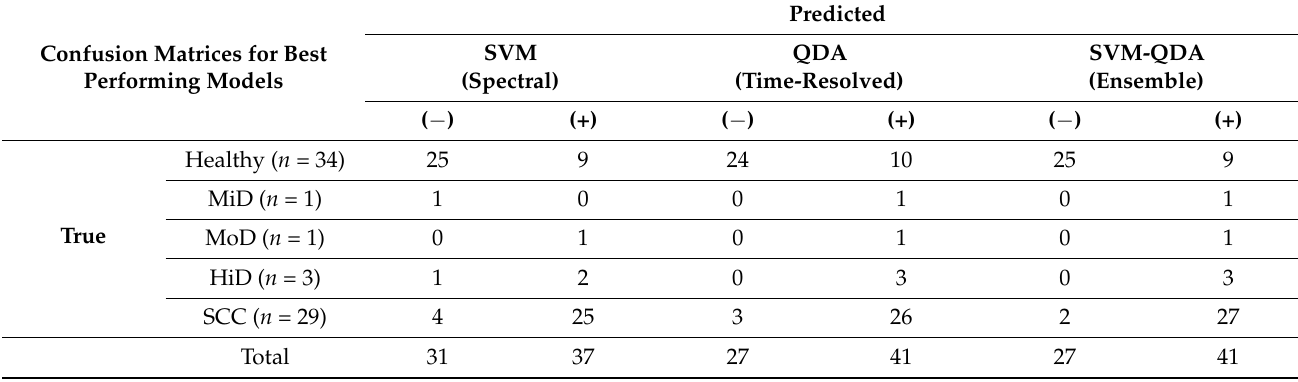
Table 5. Confusion matrices from the 7-fold cross-validation using the optimal model for each maFLIM feature pool (MiD: Mild Dysplasia; MoD: Moderate Dysplasia; HiD: High-Grade Dysplasia, SCC: Squamous Cell Carcinoma).